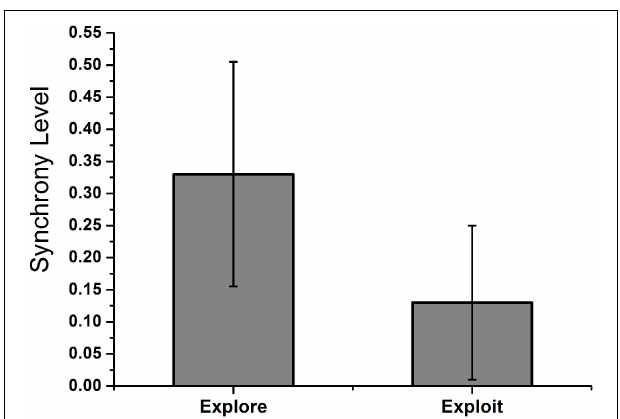
FIGURE 15 | Shows the mean “ R sync ” value of STN neurons during exploratory and exploitatory trials during the n-arm bandit task. The trials were segregated in to exploitatory or exploratory and the corresponding “ R sync ” value of STN neurons was calculated. The exploitatory trials were